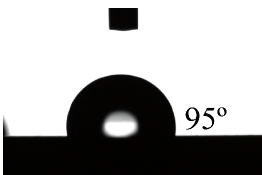
Figure 4. Water contact angle on unstructured crosslinked polycyclooctene (PCO) surface. Table 2. Height of the micropillars and contact angle on the surface of the PCO+2%DCP sample at the different steps in the shape memory process, Cycle 1 and Cycle 2.